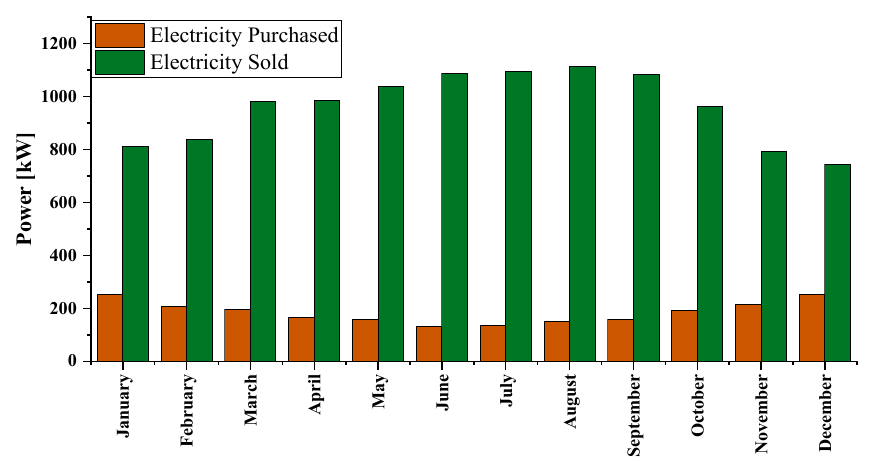
Figure 10. Average monthly purchased/sold power from/to utility grid.